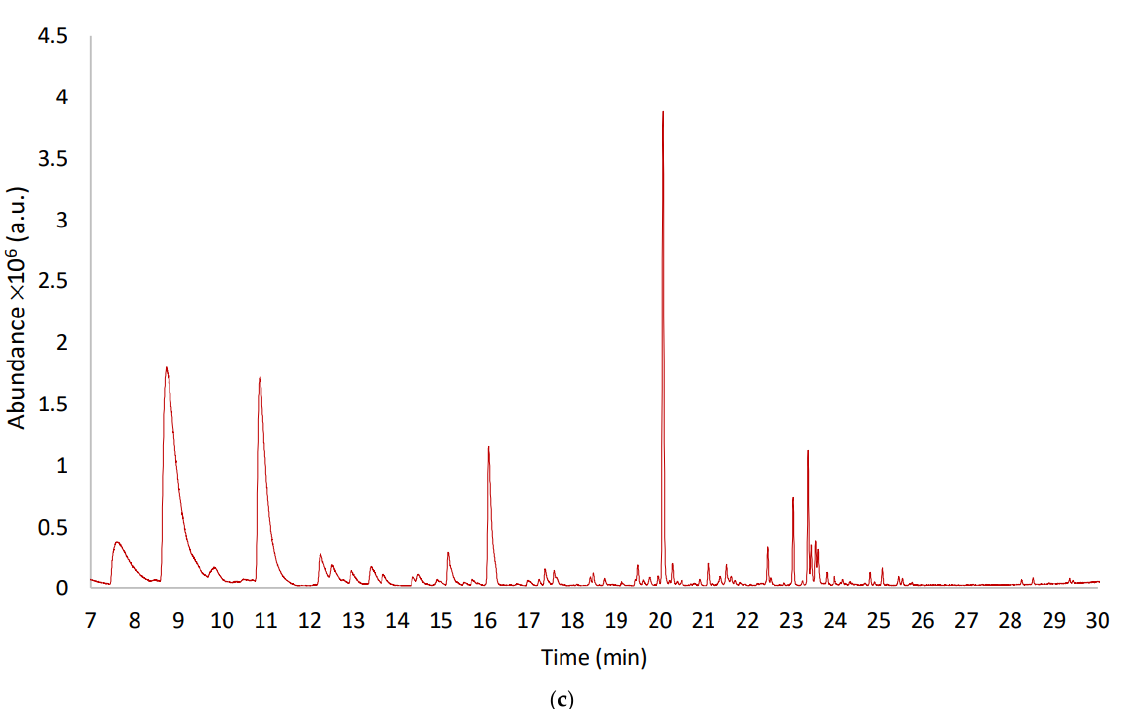
Figure 3. ( a ) TIC (Total Ion Current) chromatogram of the VOCs from G_WDF fibrous sample obtained by HS-SPME-GC-MS (a.u. = arbitrary units). ( b ) TIC chromatogram of the VOCs from AM_WDF fibrous sample obtained by HS-SPME-GC-MS (a.u. = arbitrary units). ( c ) TIC chromatogram of the VOCs from CS_WDF fibrous sample obtained by HS-SPME-GC-MS (a.u. = arbitrary units).